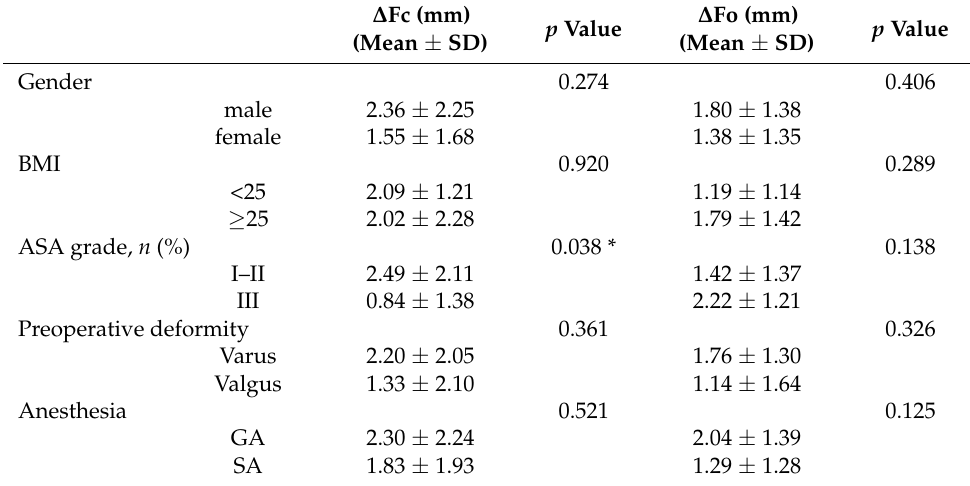
Table 3. The factors correlated to flexion gap differences measured by two methods.